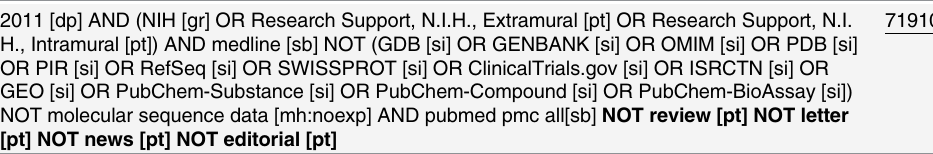
Table 5. Removal of articles that were not considered “ research ” .